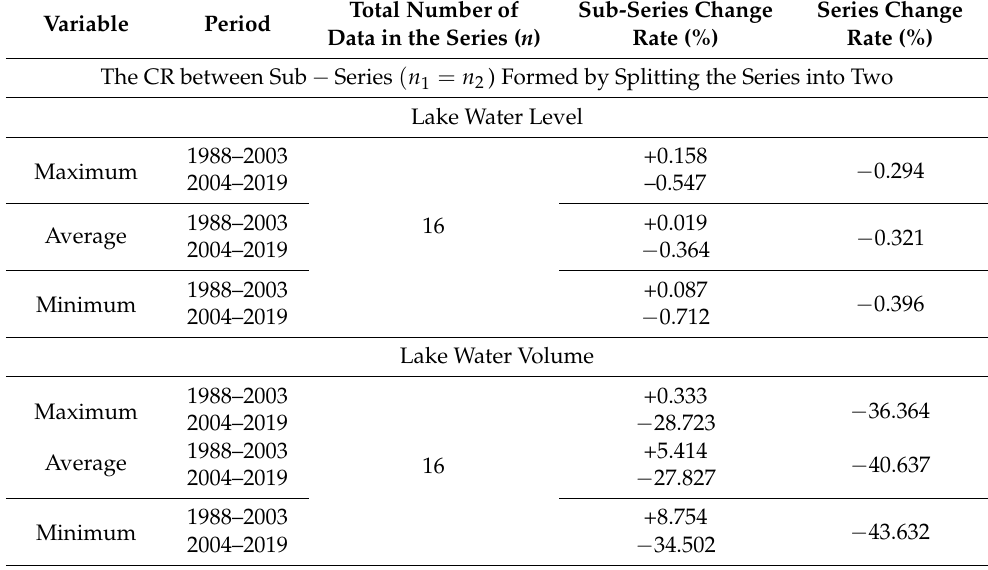
Table 6. Change rates of the annual lake water level and lake water volume in the period 1988–2019.